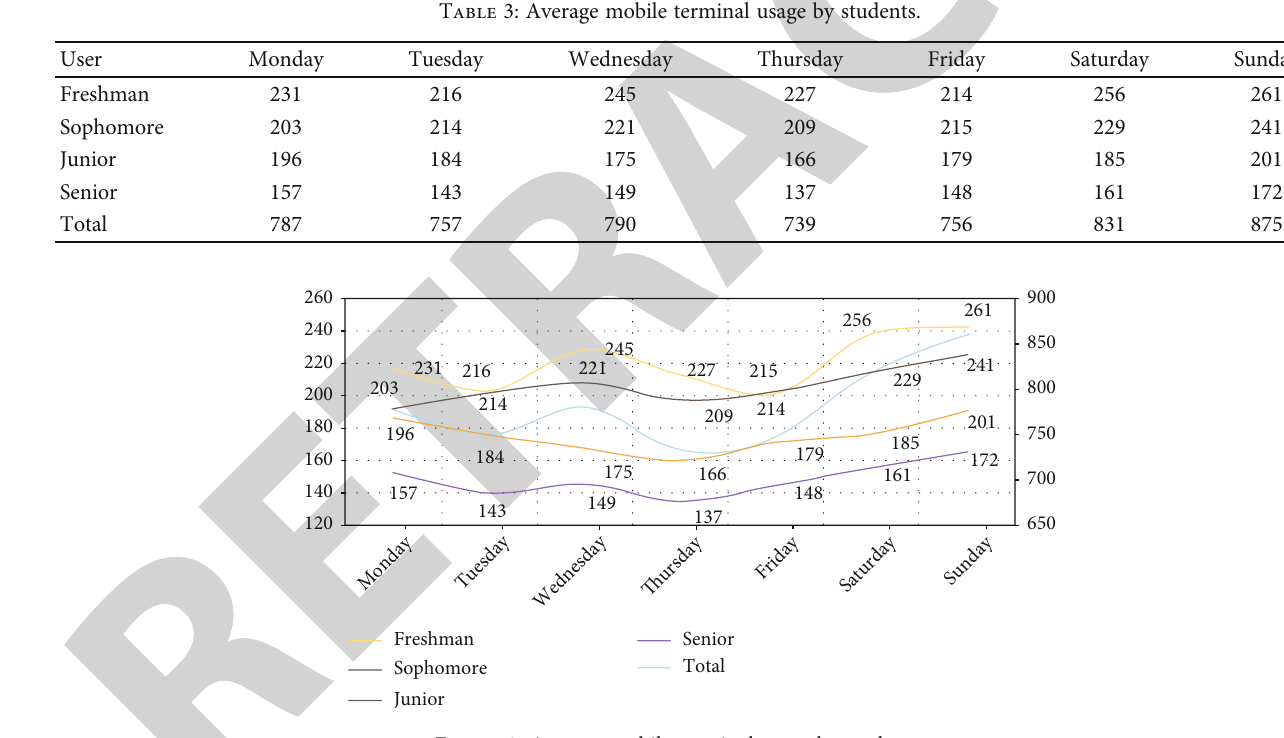
Figure 3: Average mobile terminal usage by